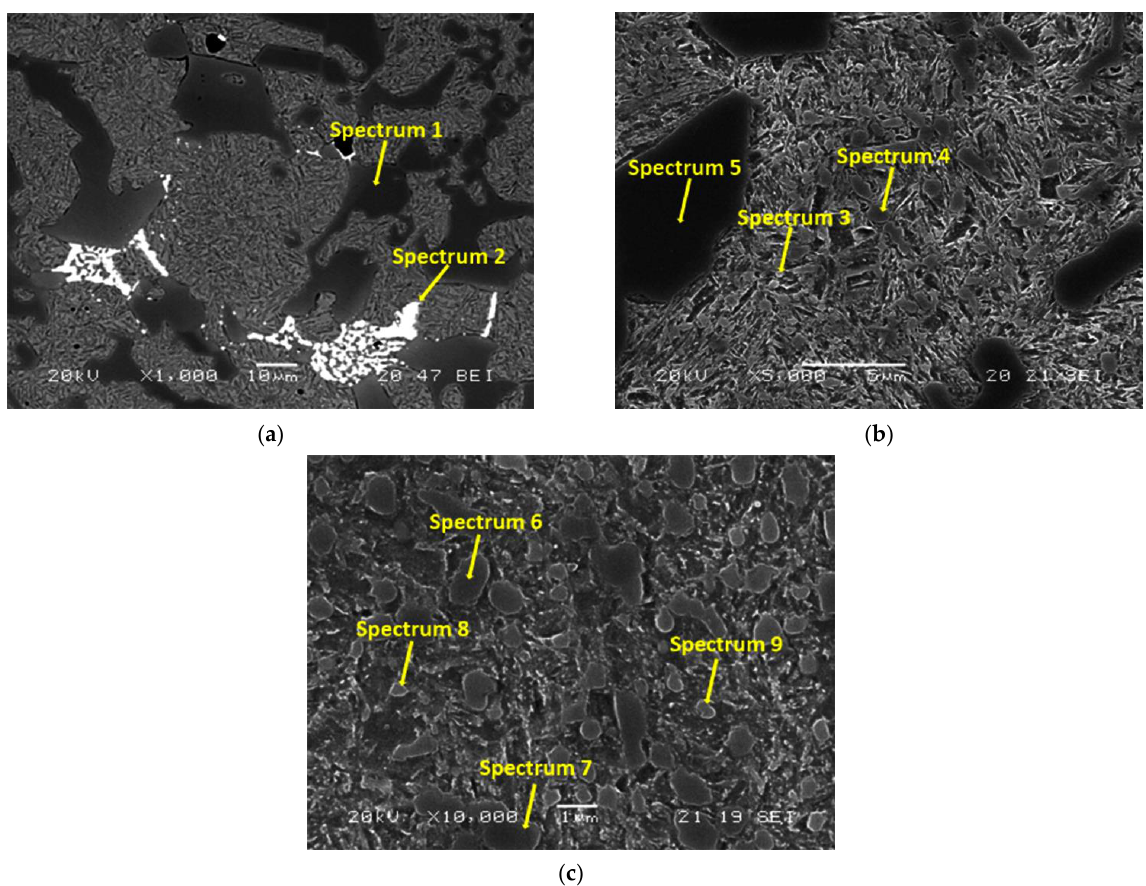
Figure 2. SEM micrographs of increasing magnification, showing the main type and morphology of carbides in selected experiments: ( a ) experiment 2 (1000×) [54]; ( b ) experiment 3 (5000×); and ( c ) experiment 5 (10,000×).